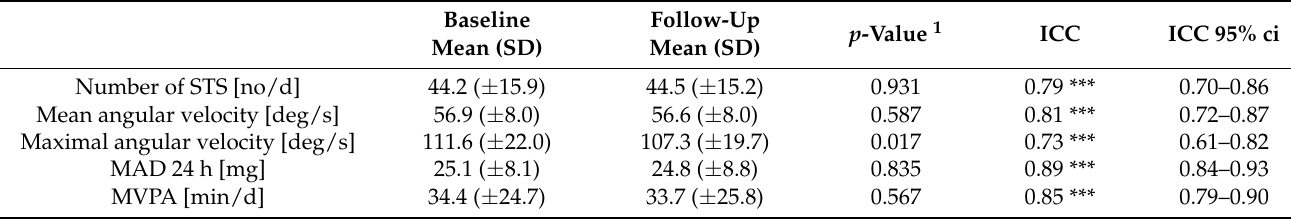
Table 2. Sit-to-stand assessment from the free-living recordings at baseline and the one-year follow-up and reproducibility of the sit-to-stand transition outcomes ( n = 86).